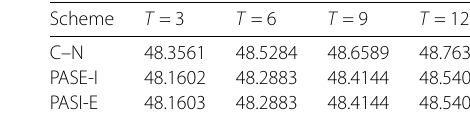
Table 1 Numerical solutions of three schemes ( α = 0.7)